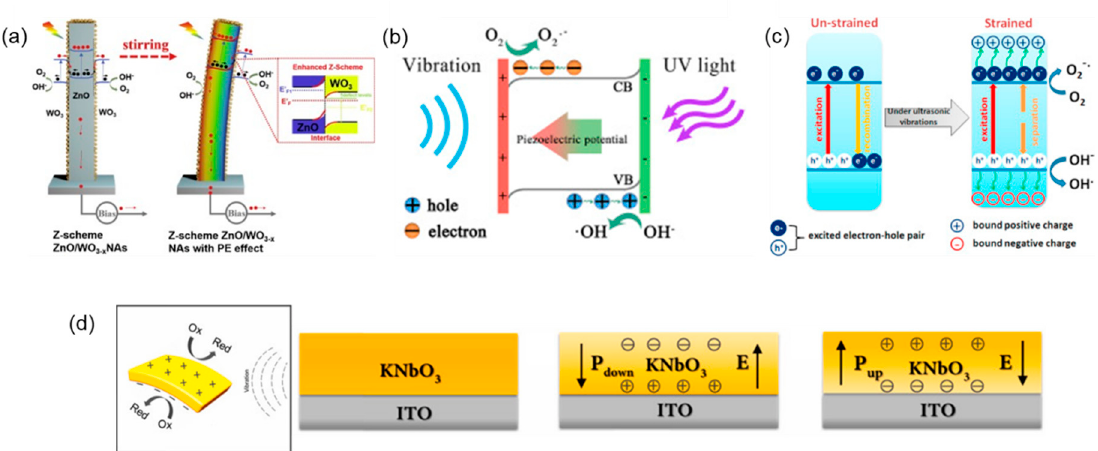
Figure 6. ( a ) Schematic illustration of piezo-phototronic effect in ZnO for water splitting. ( b ) The mechanism diagram of harvesting both photon and vibration energy, i.e., piezo-phototronic effect. ( c ) Schematics of the exciton separation mechanism in the un-strained and strained NaNbO 3 . ( d ) Schematic illustration of the piezo-catalytic reaction mechanism for the KNbO 3 (without poling, with negative poling and with positive poling conditions). ( a ) Reproduced from [65], Copyright 2019, Elsevier. ( b ) Reproduced from [66], Copyright 2019, Elsevier. ( c ) Reproduced from [68], Copyright 2017, Elsevier ( d ) Reproduced from [69], Copyright 2019,